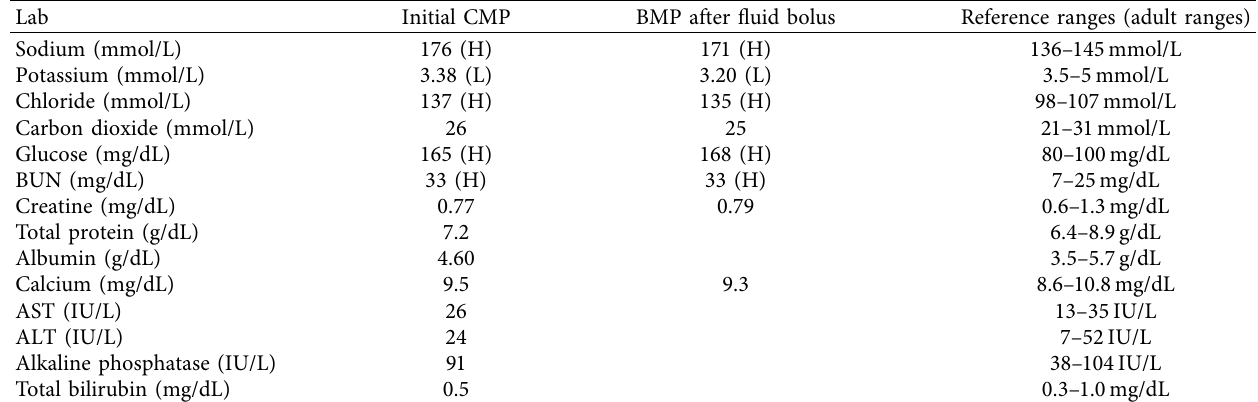
Table 1: Initial electrolytes obtained at outside